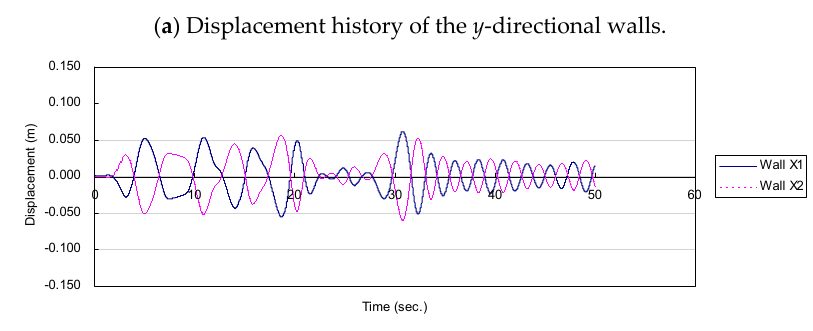
( b ) Displacement history of the x -directional walls.